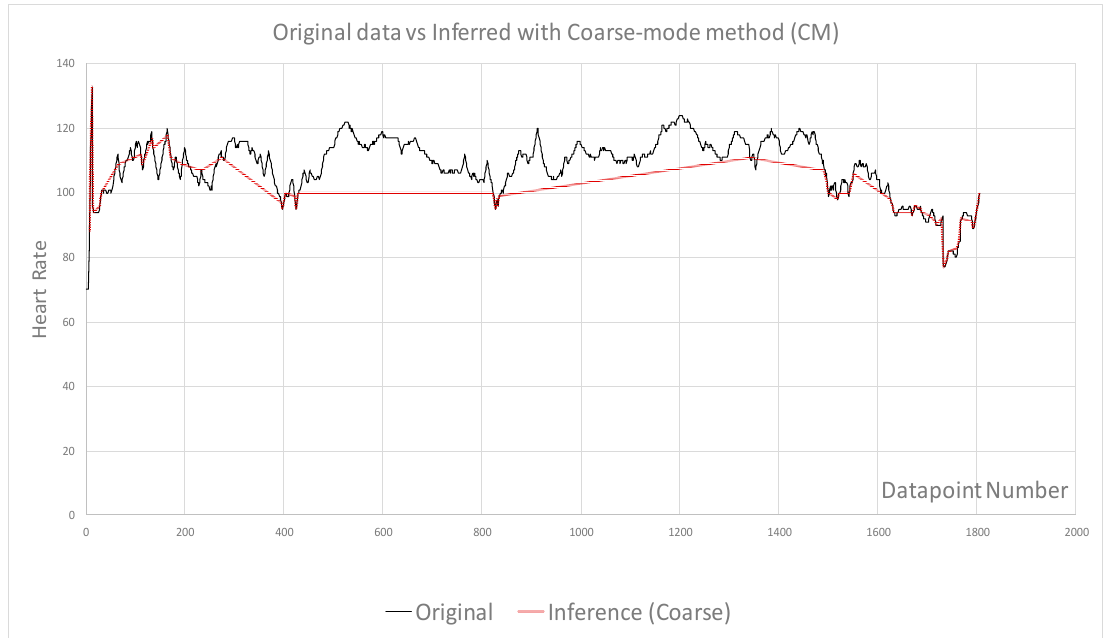
Figure 6. Original data points versus Coarse-mode method (CM) applied for inference (original DP: 1800, inferred DP: 139). Data are distorted considerably without beacons.